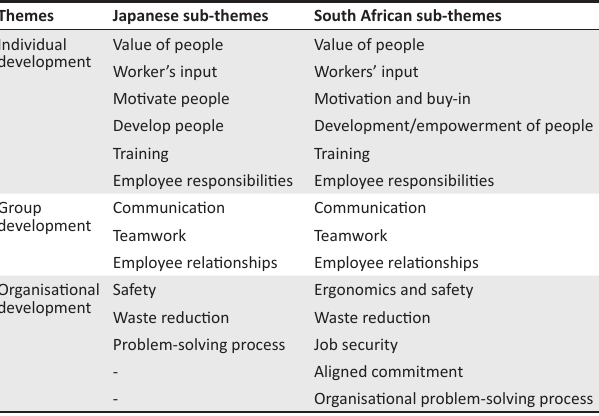
TABLE 4: Comparison between Japanese Respect for People principles and South African Respect for People